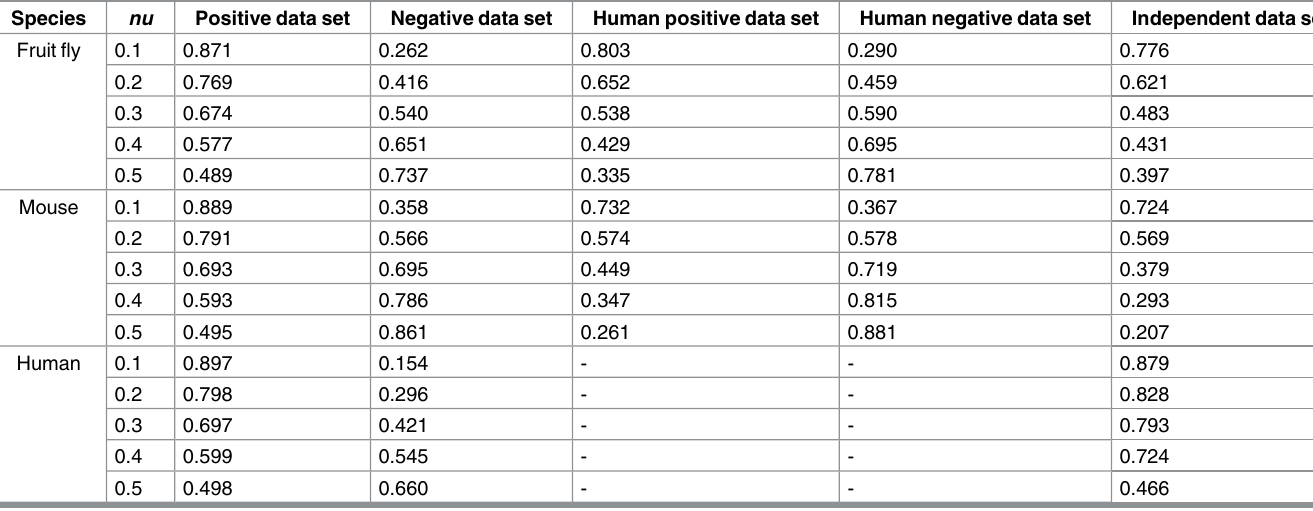
Table 2. The performances of one-class classification. Species